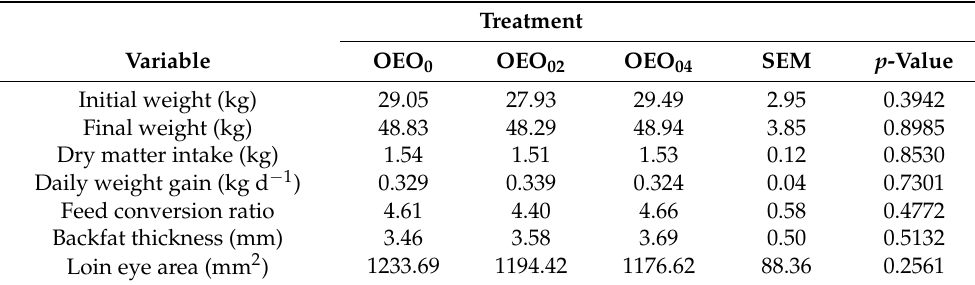
Table 2. Productive performance, loin eye area, and backfat thickness in lambs fed with different OEO levels in the